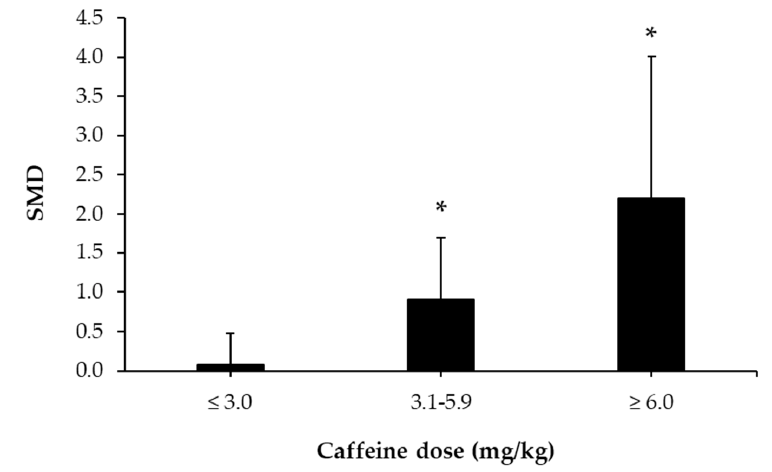
Figure 3. Dose–response effect of caffeine ingestion as compared to a placebo on fat oxidation rate during exercise. SMD values are the standardized mean difference values obtained with a meta-analysis of 19 studies and the bar represents 95% confidence intervals for the SMD for each dosage. (*) The effect of caffeine at this dosage was statistically significant, with a higher fat oxidation rate observed compared to placebo ingestion ( p < 0.05).